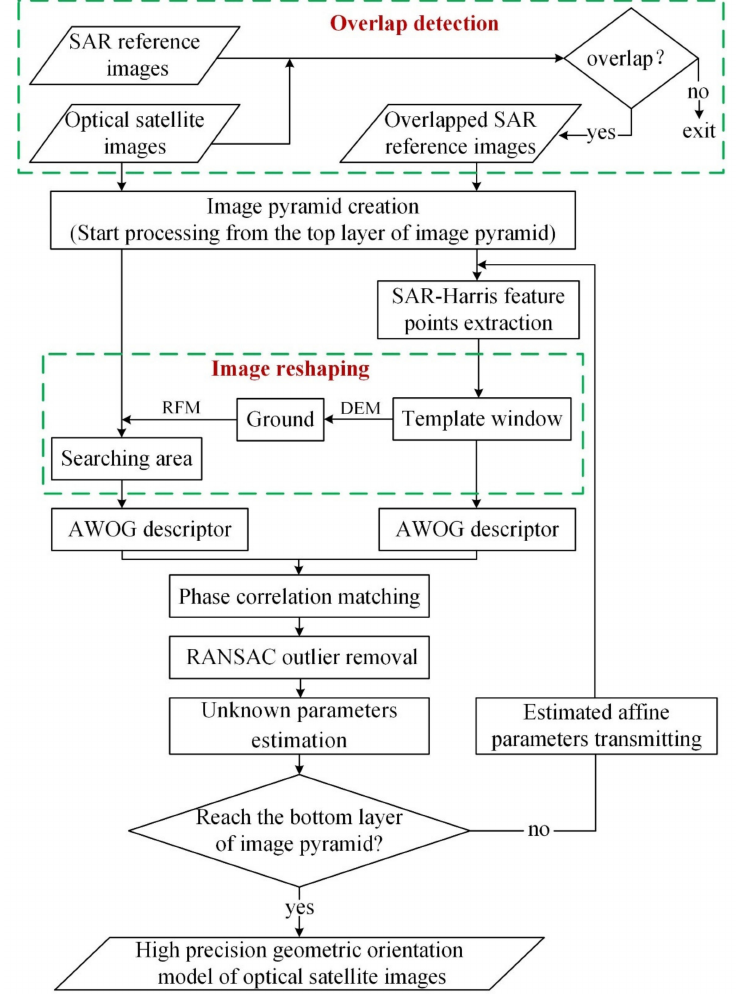
Figure 8. Flowchart of the proposed geometric orientation